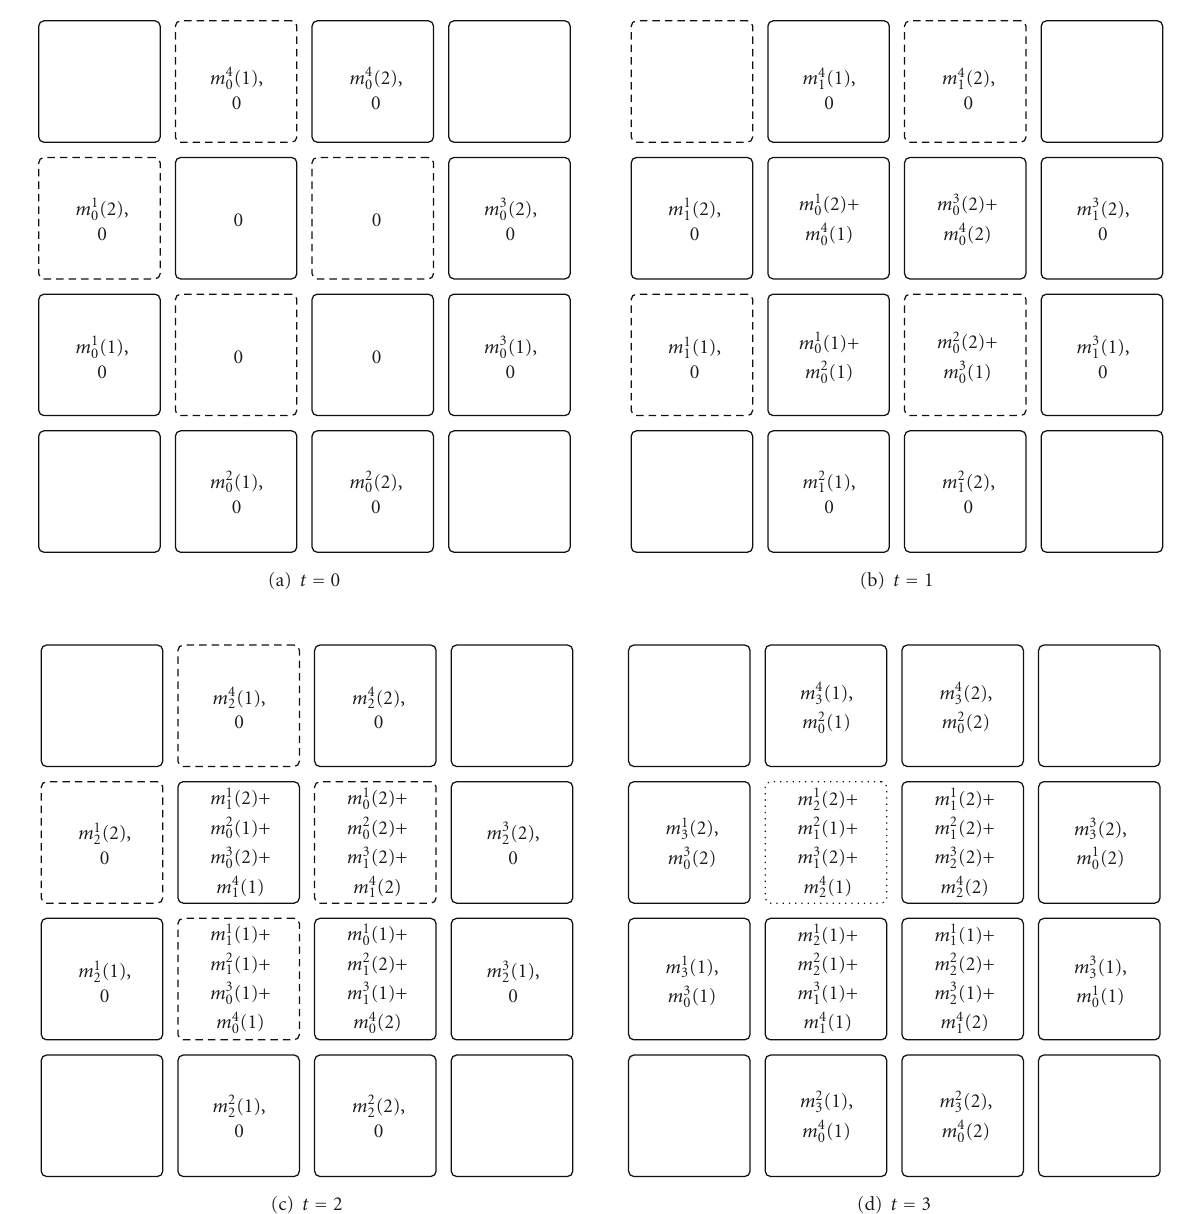
Figure 8: Example operation of the network code of Section 5, with K = 3. The transmissions of all nodes in the time slots 0, ... ,3 are depicted. Di ff erent transmissions by the same node are separated by a comma. Note, that the symbol transmitted at t = 3 by the node with dotted border can be obtained by summing all transmissions from nodes with a dashed border in earlier time slots. All nodes in the interior of the network perform this simple coding